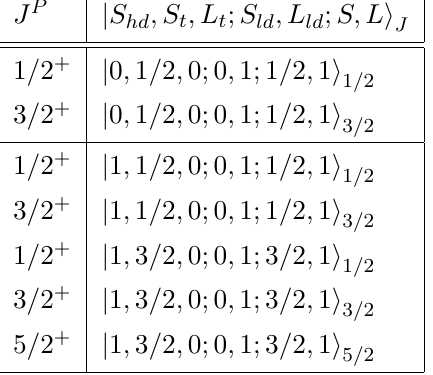
Table 5 . Spin-parity J P and state vectors of the P -wave pentaquarks with the ground- state triquark ( L t = 0) and \bad" light di- quark with the spin S ld = 1. The horizontal line demarcates the spin S hd of the heavy di-